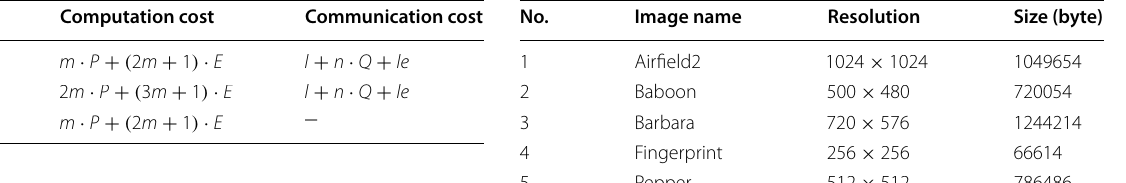
Table 1 General analysis of our scheme Algorithm